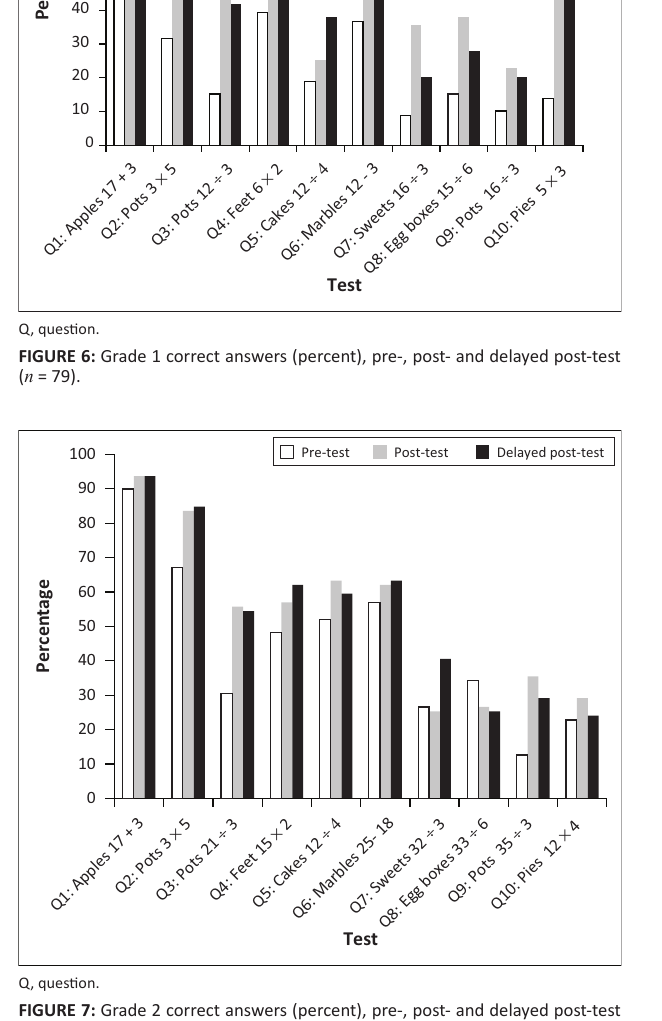
FIGURE 7: Grade 2 correct answers (percent), pre-, post- and delayed post-test ( n = 79).